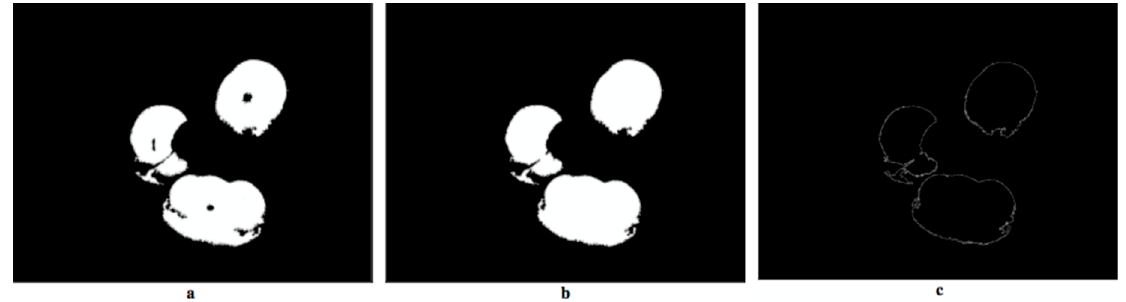
Figure 15. ( a ) Segmentation based on size 2; ( b ) gap filling; and ( c ) external